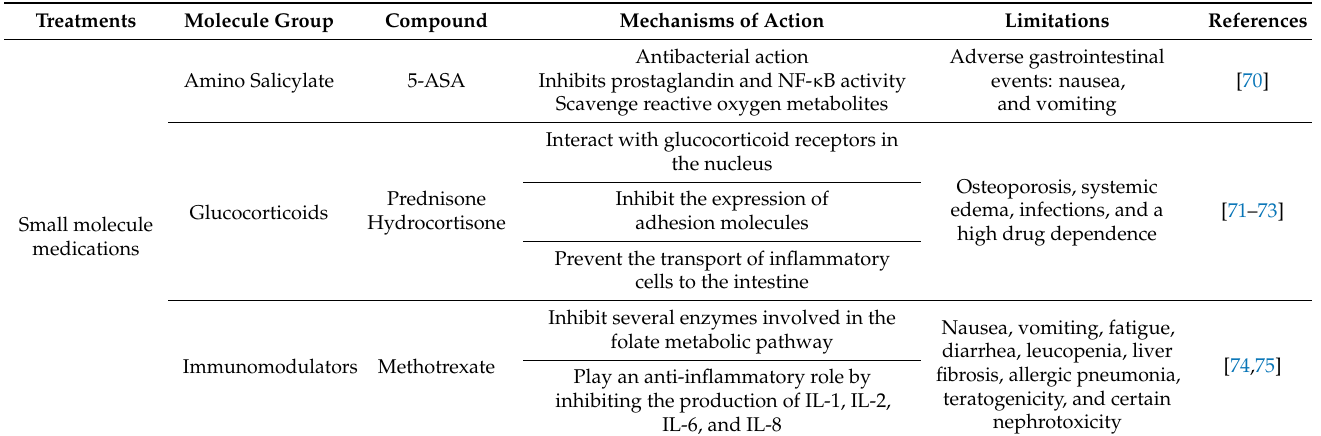
Table 1. Summary of novel medications intended for the management of IBD.